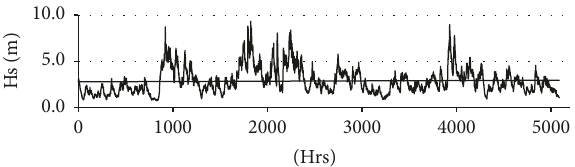
Figure 2: Plot of the September–April Hs time series of